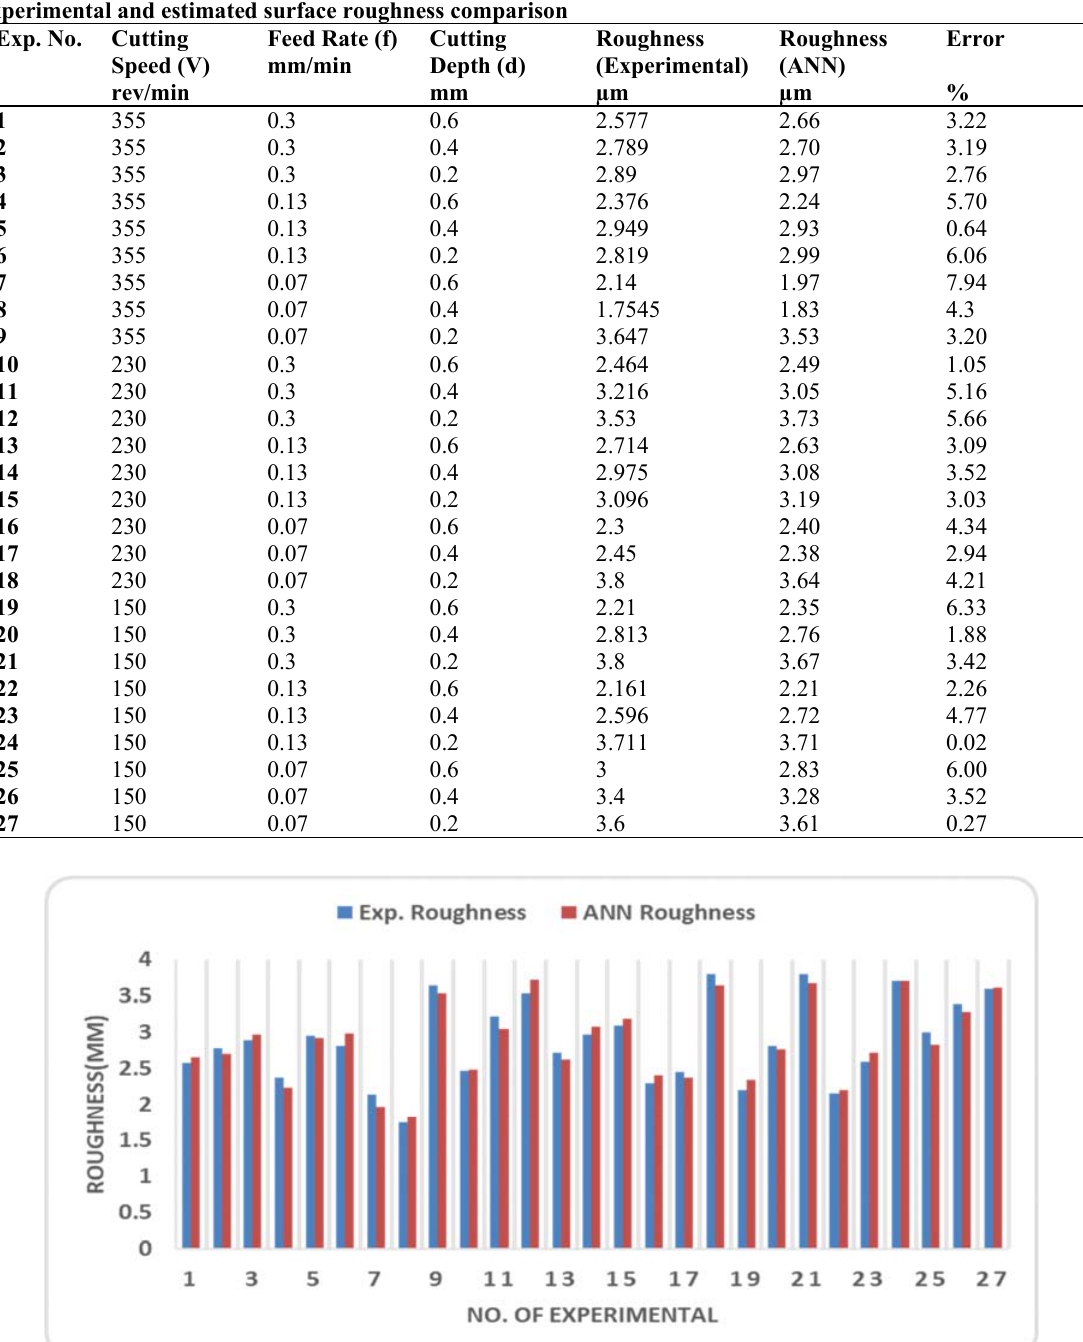
Fig. 6. Experimental and estimated surface roughness comparison at different cutting conditions